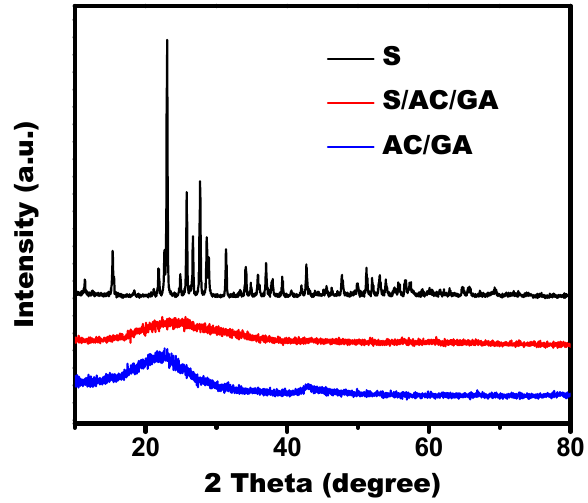
Figure 2. X-ray diffraction (XRD) patterns of elemental sulfur, AC/GA and S/AC/GA composites.